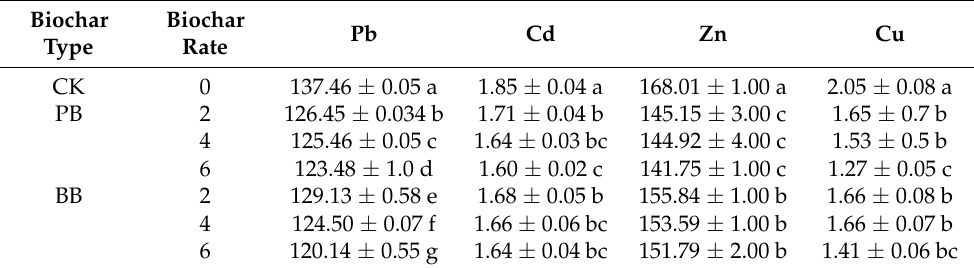
Table 4. Concentration of the acid extractable fraction of soil heavy metals (mg kg − 1 ) determined with the BCR sequential extraction method.